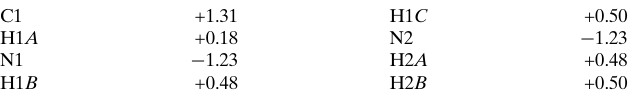
Table 2 Calculated Bader atomic charges for the isolated symmetric formamid- inium cation. The order of the atoms in the isolated cation matches with that in the formamidinium cation in the refined crystal structure. C1